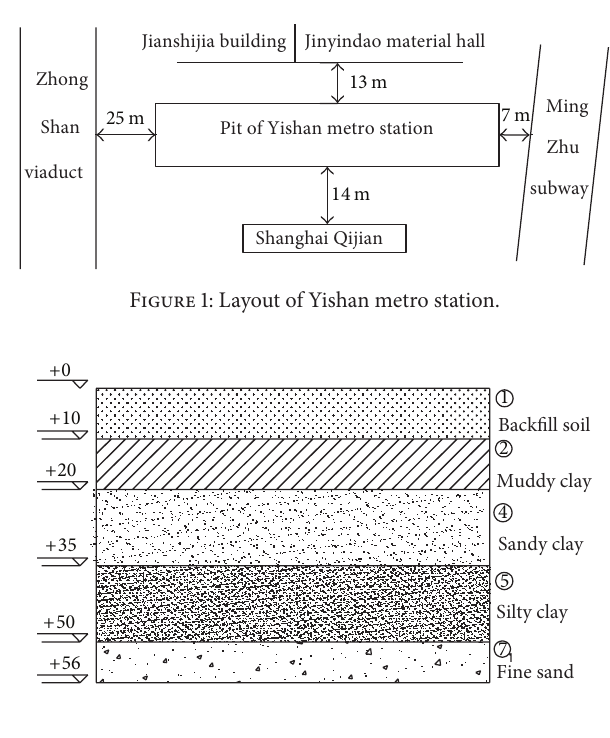
Figure 2: Geological section of Yishan metro